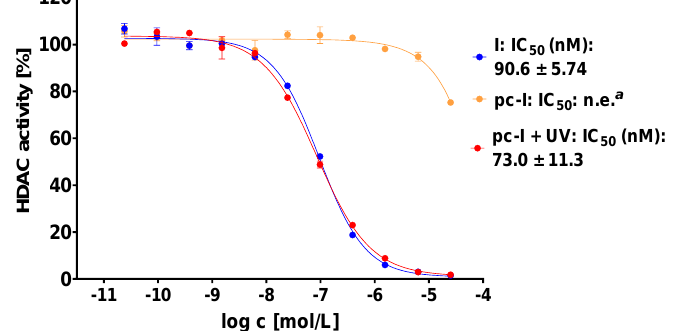
Figure 3. Representative concentration-effect curves of the whole-cell HDAC inhibition assays of pc-I and I in MV-3 cells. Stated IC 50 values were determined from the mean of three independent experiments in duplicates. Irradiation with UV light was executed at 365 nm for 10 min. a n.e: no effect: <25% inhibition at 25 µM.